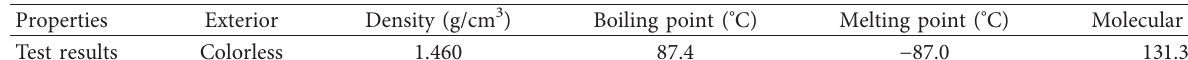
Table 5: Properties of trichloroethylene (TCE).